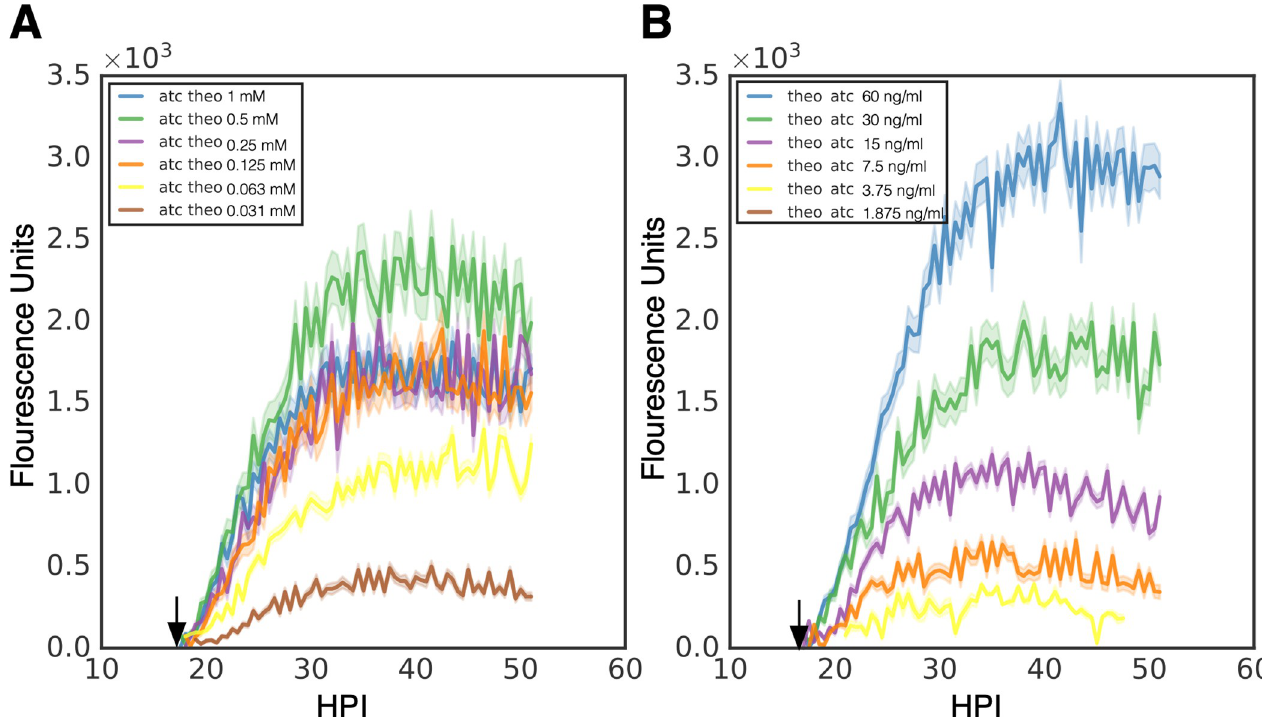
Fig 4. Induction kinetics of p2TK2-SW2-Tet-J-E-clover-flag. A) Cos-7 cells were infected with L2-Tet-J-E-clover-flag, treated with varying dilutions of theophylline at 16 hpi (1 mM, 0.5 mM, 0.25 mM, 0.125 mM, 0.0625 mM, 0.03125mM) and 30 ng/ml aTc at 0 hpi. The infections were monitored using live cell imaging for 50 hours. B) Cos-7 cells were infected with L2-Tet-riboJ-E-clover-flag, treated with varying dilutions of aTc at 16 hpi (60 ng/ml, 30 ng/ml, 15 ng/ ml, 7.5 ng/ml, 3.75 ng/m, 1.875 ng/m) and 0.5 mM theophylline at 0 hpi. The infections were monitored using live cell imaging for 50 hours. Expression intensities from > 50 individual inclusions were monitored via automated live-cell fluorescence microscopy and the mean intensities are shown. Cloud represents SEM. Y-axes are denoted in scientific notation.